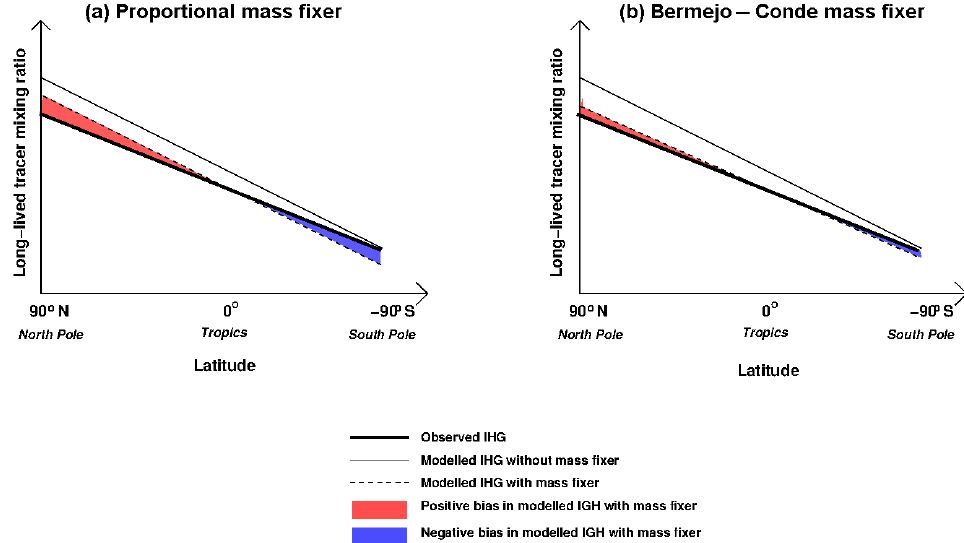
Figure 11. Schematic illustrating the impact of the (a) proportional and (b) Bermejo–Conde mass fixers on the inter-hemispheric gradient of XCO 2 and XCH 4 . Note that the area between the dash line and thin solid line depicting the global correction of tracer mass should be the same for the two mass